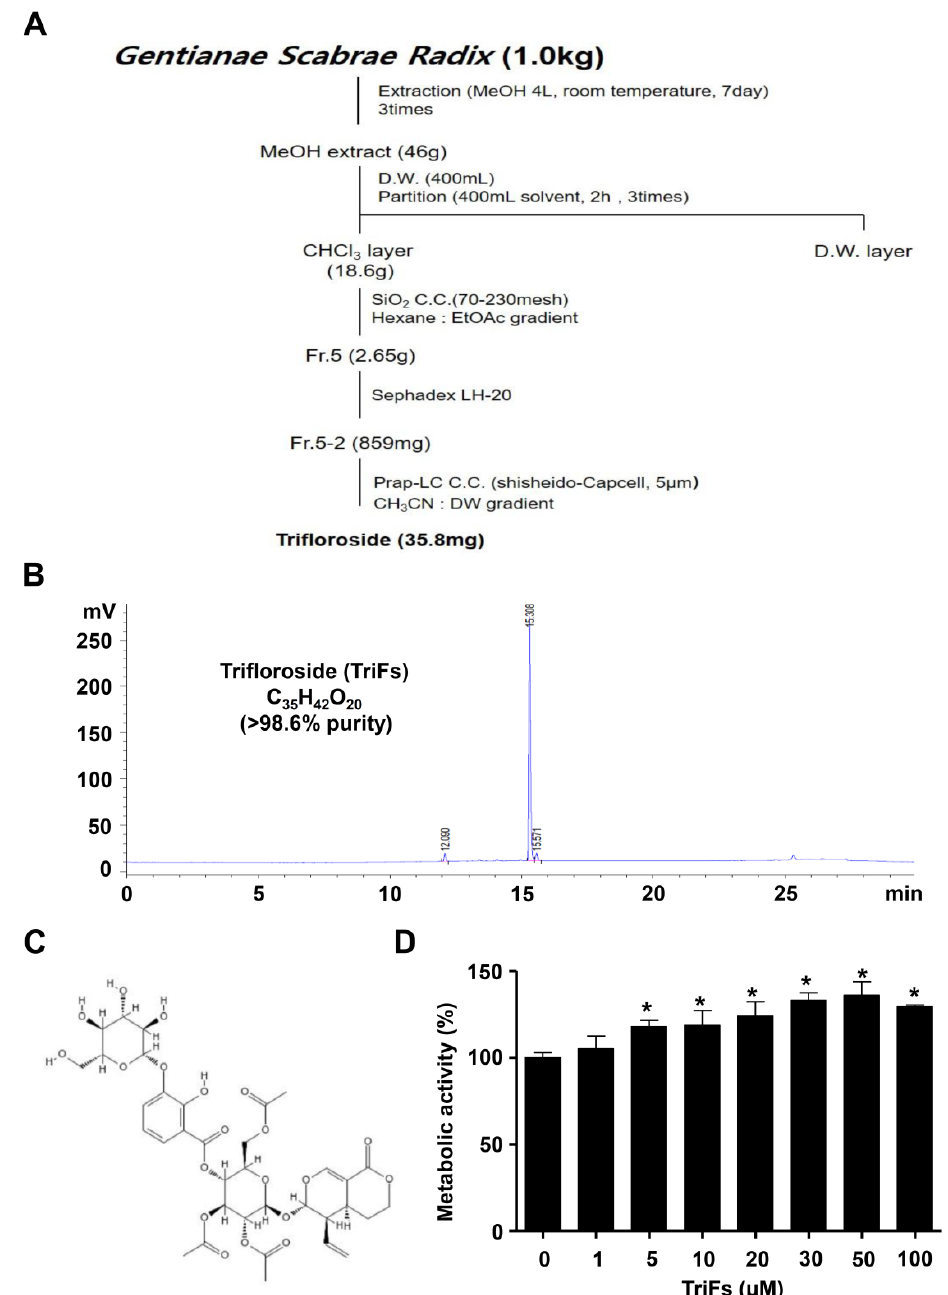
Figure 1. Purification of trifloroside (TriFs) from Gentianae Scabrae Radix roots and its effect on MTT assay. ( A ) Procedure for extracting TriFs from the roots of Gentianae Scabrae Radix. ( B , C ) high-performance liquid chromatography (HPLC) ( B ) and structure ( C ) of TriFs (C 35 H 42 O 20 , >98.6% purity). ( D ) Cell metabolic activity was determined using an MTT assay after pre-osteoblasts were treated with TriFs at doses of 1–100 μ M for 24 h. *, p < 0.05 indicates significant differences when compared to the control. Data are presented as mean ± standard error of the mean (S.E.M.). Data shown are from three independent trials.